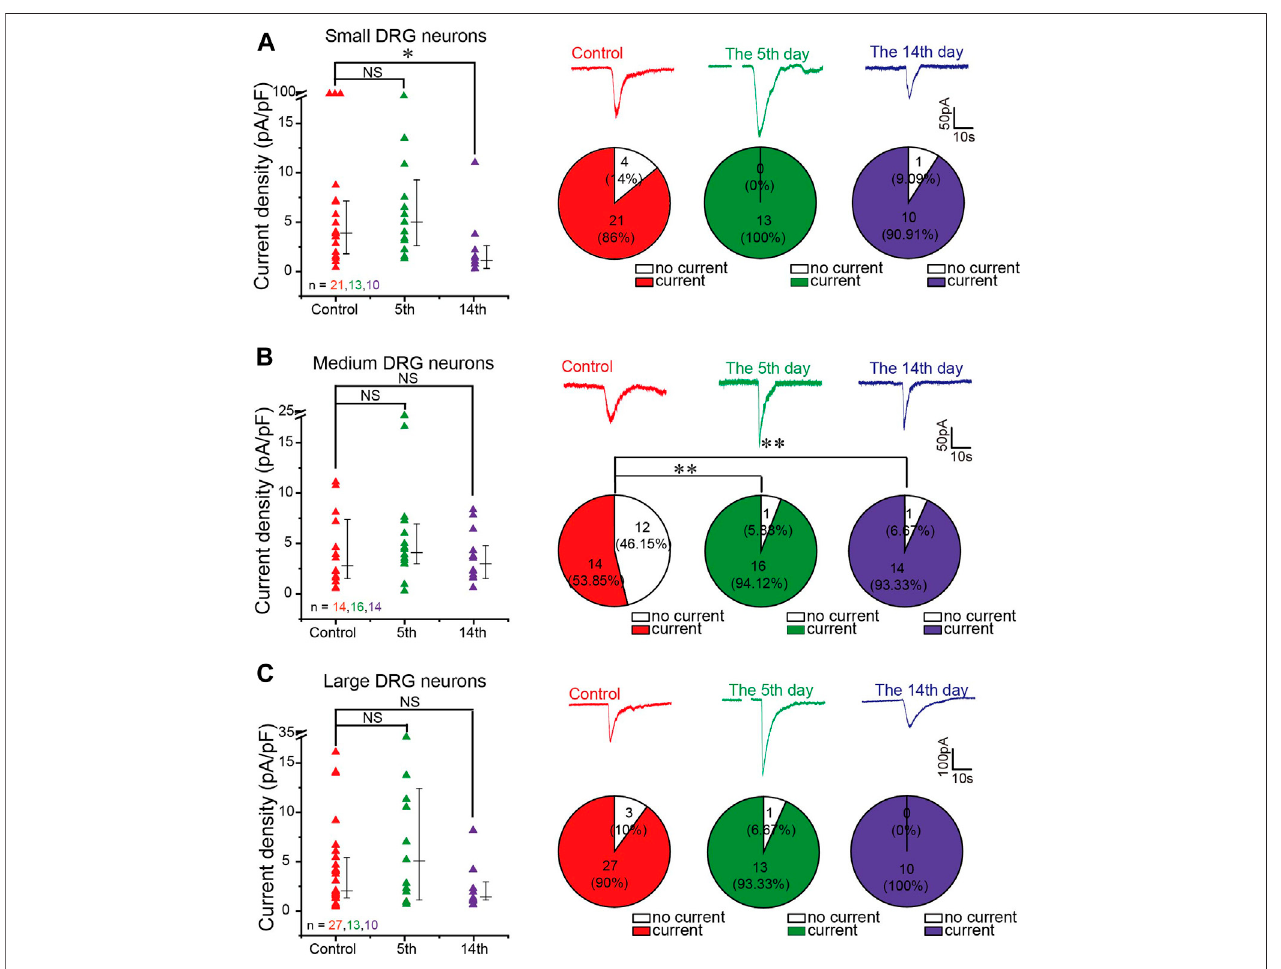
FIGURE 4 | GABA-evoked current from DRG neurons of neuropathic pain rats. (A – C) Comparison of GABA (200 μ M)-induced currents from isolated and cultured L4 – 6 DRG neurons from sham-operated and CCI-operated rats on the 5th and 14th days after surgery. Left panels are scatter plots of GABA current densities induced by GABA (200 μ M) from small (A) , medium (B) , and large DRG neurons (C) from different groups of rats, respectively, * p < 0.05 (Mann – Whitney test). Right panels are representativetracesofGABAcurrentsrecordedataholdingpotentialof − 60 mV(top)andthecomparisonoftheproportionofGABA-respondingandnonresponding DRG neurons between different groups (bottom) were tested using Pearson ’ s chi-square test, ** p < 0.01. Number of experiments is indicated as n in each panel.